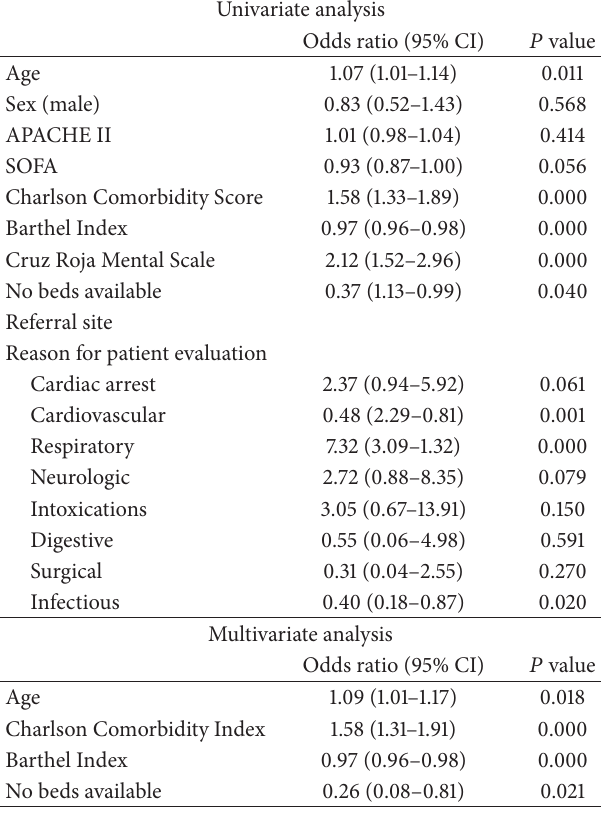
Table 5: Factors associated with ICU